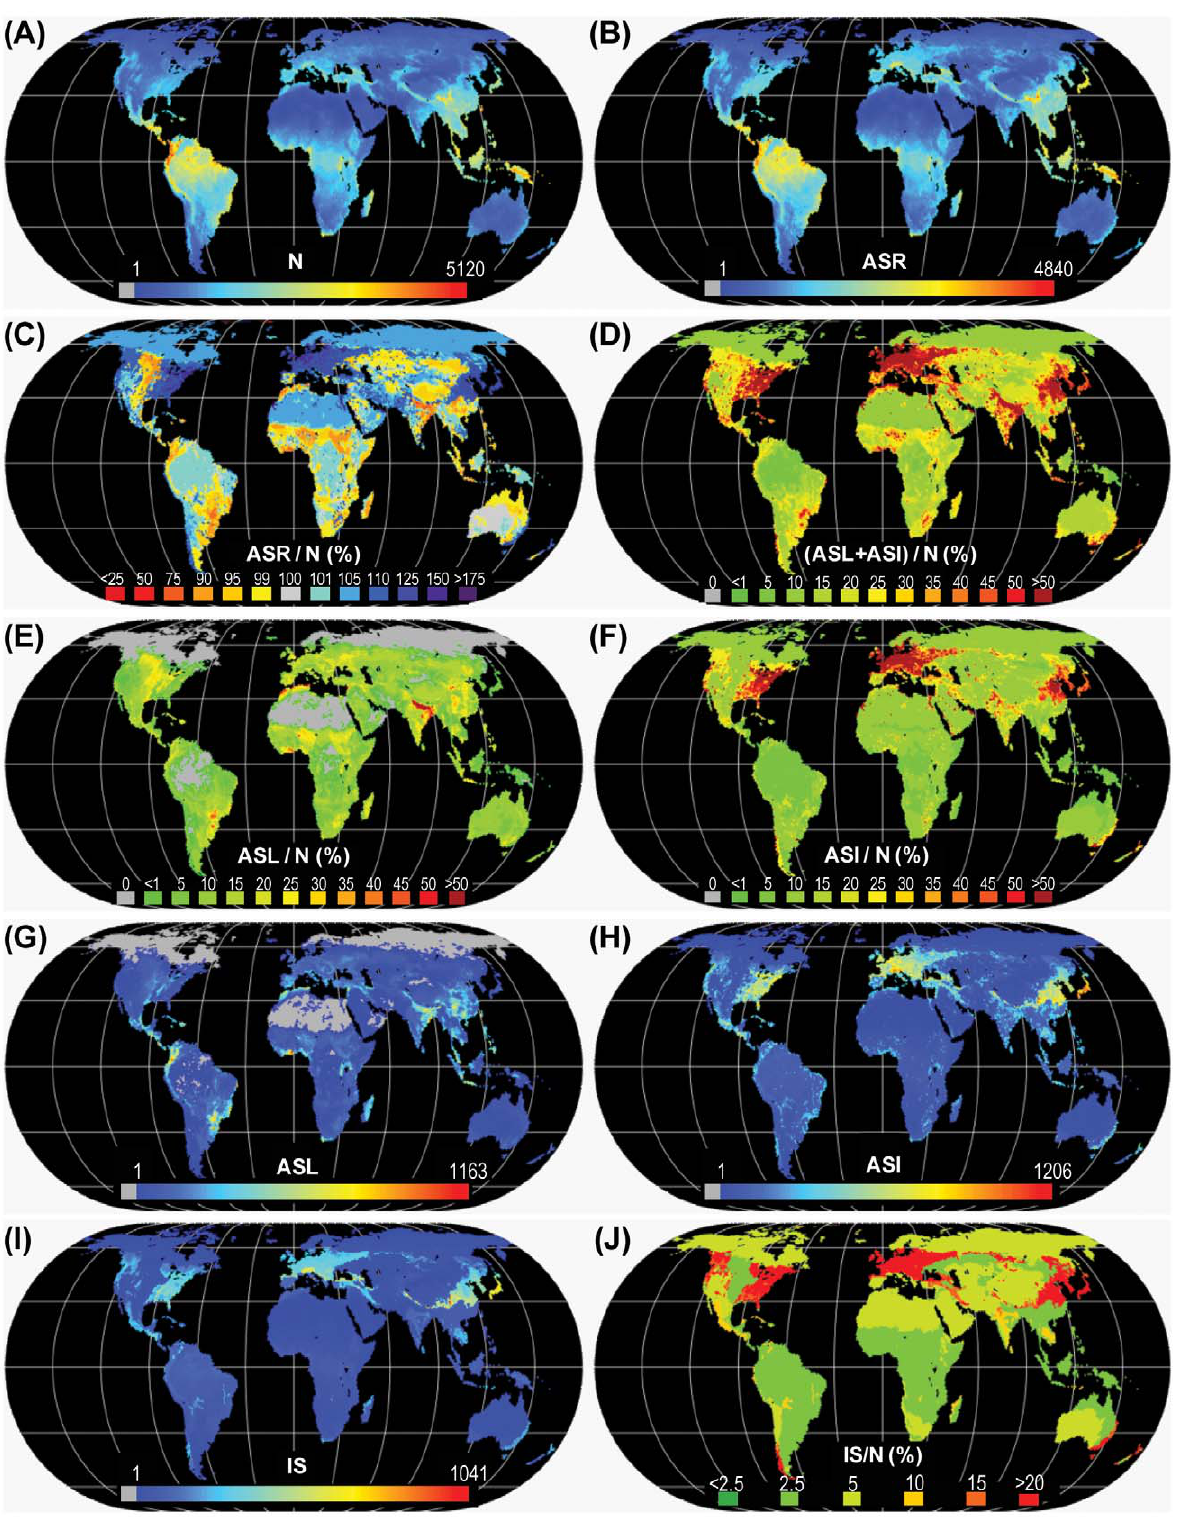
Figure 1. Global maps of (A) Native species richness ( N ), (B) Anthropogenic species richness ( ASR ), (C) Anthropogenic species richness ( ASR ) relative to N , (D) total anthropogenic species loss ( ASL ) + anthropogenic species increase ( ASI ) relative to N , (E) ASL relative to N , (F) ASI relative to N , (G) ASL , (H) ASI , (I) exotic species invasions ( IS ), (J) IS relative to N . All maps in Eckert IV global equal area projection.